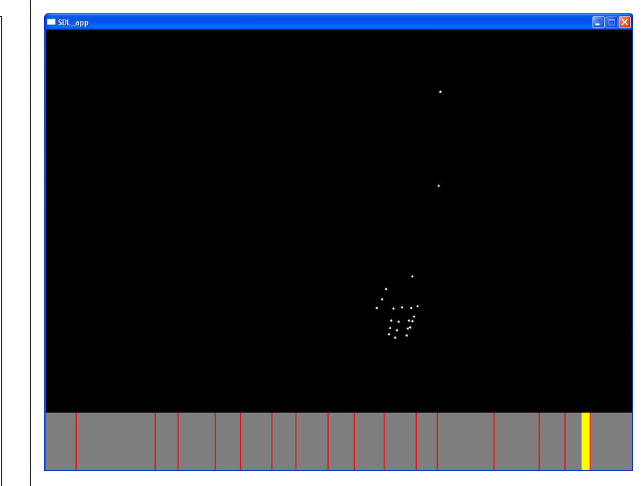
Figure 3 | Five frames at 4 s intervals from the drink from mug sequence, inverted.